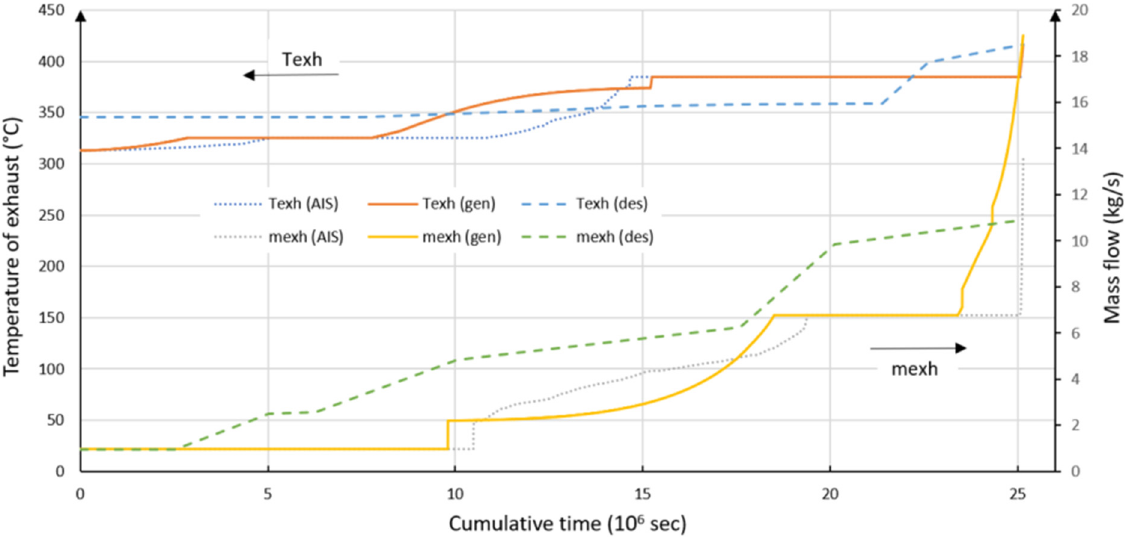
Figure 10. Comparison of exhaust gas profile using AIS, generic and design operational profiles.